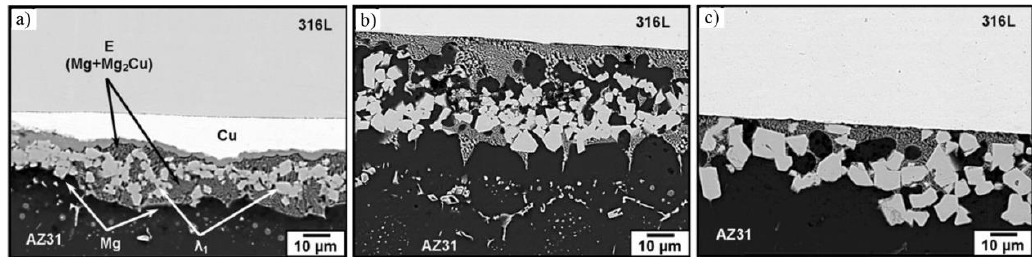
Figure 8. SEM micrographs of AZ31/Cu/316 L joint at 530 °C with different bonding time [29] ( a ) 5 min; ( b ) 15 min; ( c ) 30 min.